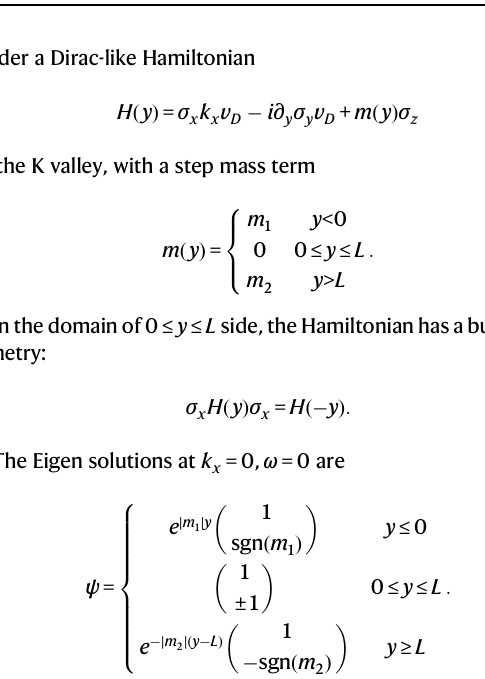
Fig. 1 | Boundary condition induced CABSs. a Schematic of the PC with a hard boundary. b Bulkband diagram. Insetimages: the corresponding pressure(colors) andenergy fl ux fi elds(arrows)oftheeigenstatesintheunitcell.Thered(blue)band is even (odd) with respect to the mirror plane marked by the dotted line. c Band dispersionof thePCwithahardboundary,wherethe periodicboundarycondition